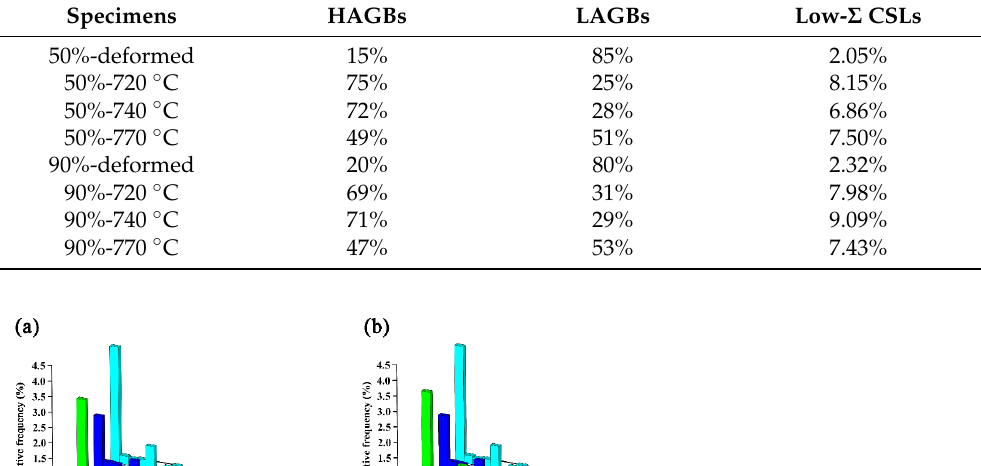
Figure 11. Misorientation distributions of X2CrNi12 steel at 50% deformation ( a ) and 90% deformation ( b ) with different annealing temperatures. Table 2. Grain boundary distribution of X2CrNi12 steel specimens.